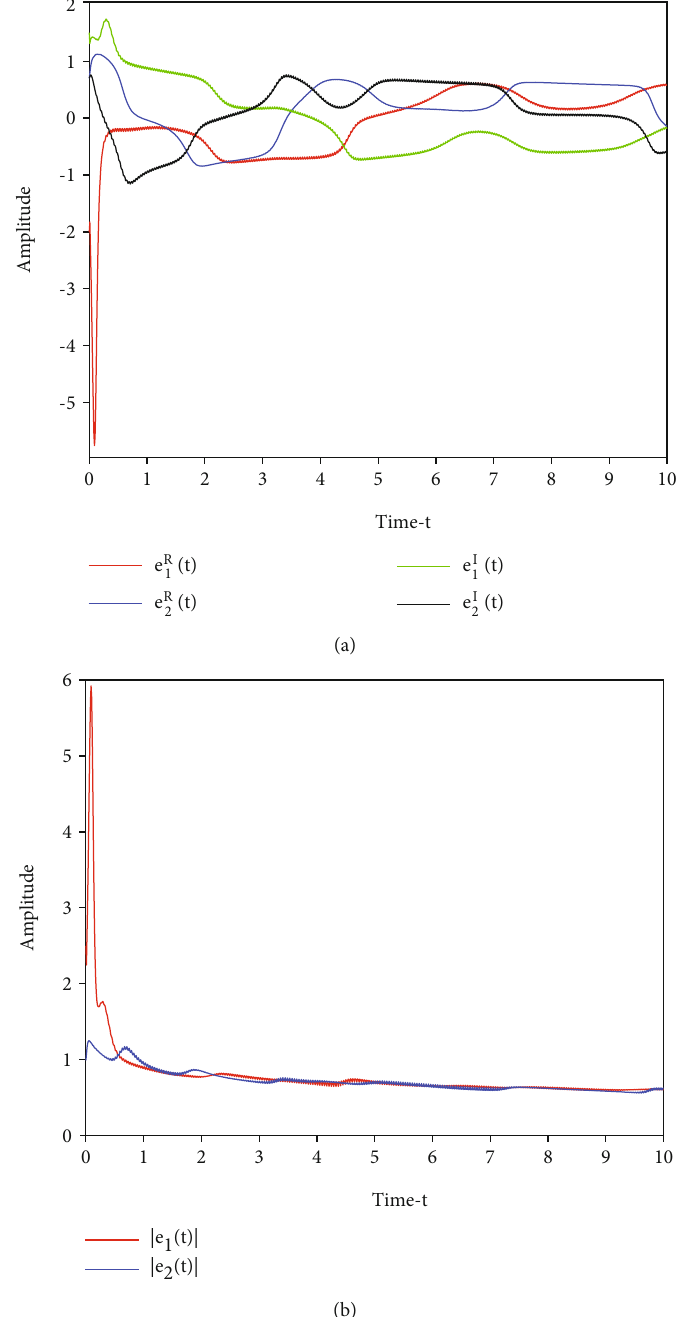
Figure 1: The error trajectories of FCVCGNNs without the controller. (a) The curves of real parts and imaginary parts. (b) The curves of modulus of